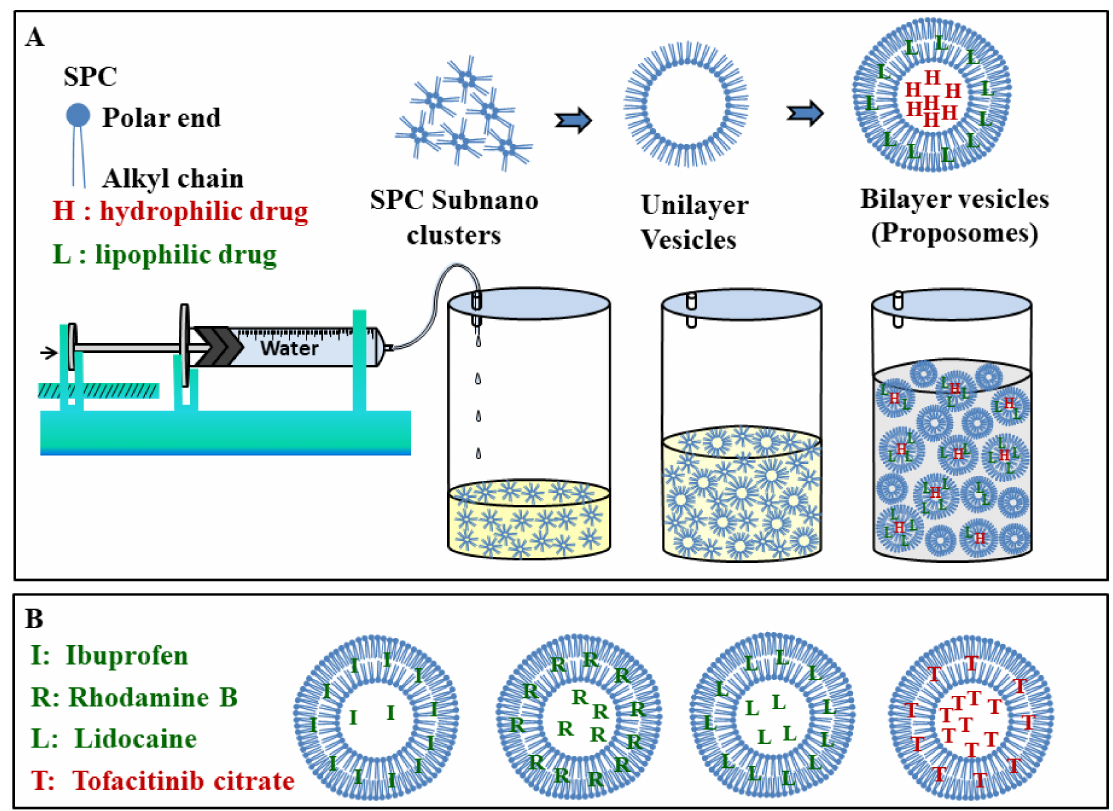
Figure 2. ( A ) Schematic of preparation process. The dropwise addition of water into PG (also SPC and drug) with constant magnetic stirring causes proposome formation by rearrangement of SPC molecules to the vesicular structure. ( B ) Probable distribution of drug molecules in the proposomes. Lipophilic drugs are more likely in bilayer and less likely in the core while it is reverse for hydrophilic